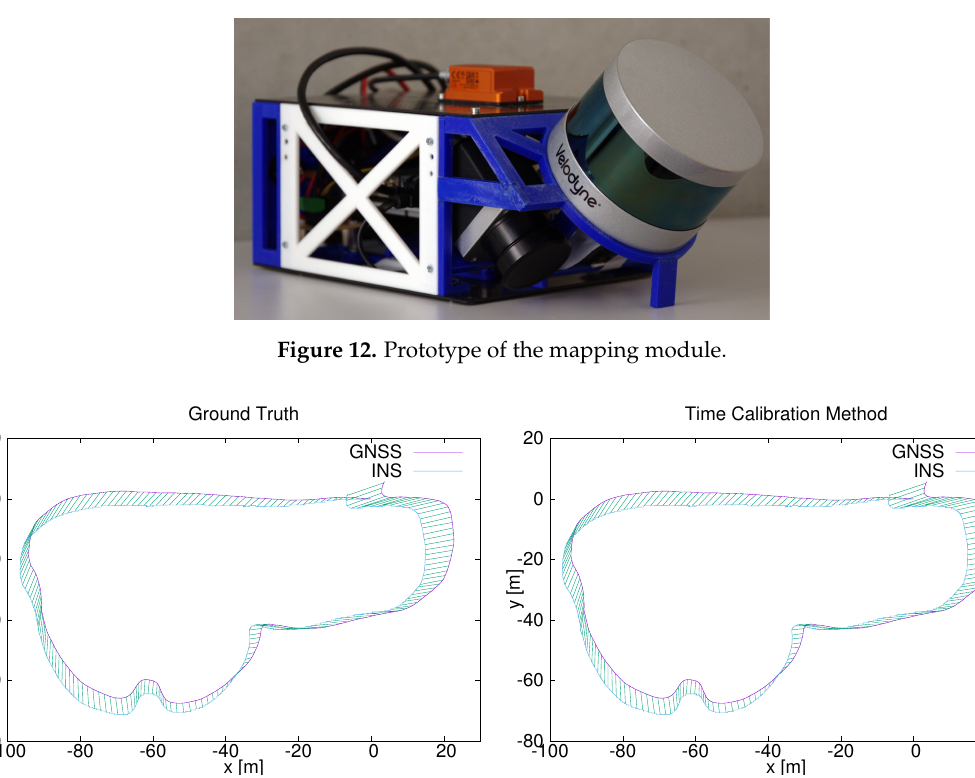
Figure 13. Data synchronization results. ( Left ): Synchronizing data by GPS timestamps (ground truth). ( Right ): Synchronizing data by the proposed time-calibration method. The trajectory is from the computer science building data